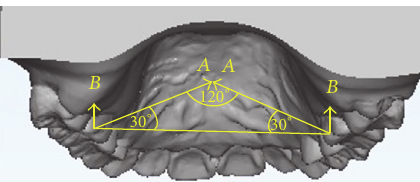
Figure 3: The force magnitude ( 𝐴 ) of each nickel-titanium closed coil spring was 100 g per side. The magnitude of the resultant intrusive force ( 𝐵 ) for either right or left side was equal to 50g.